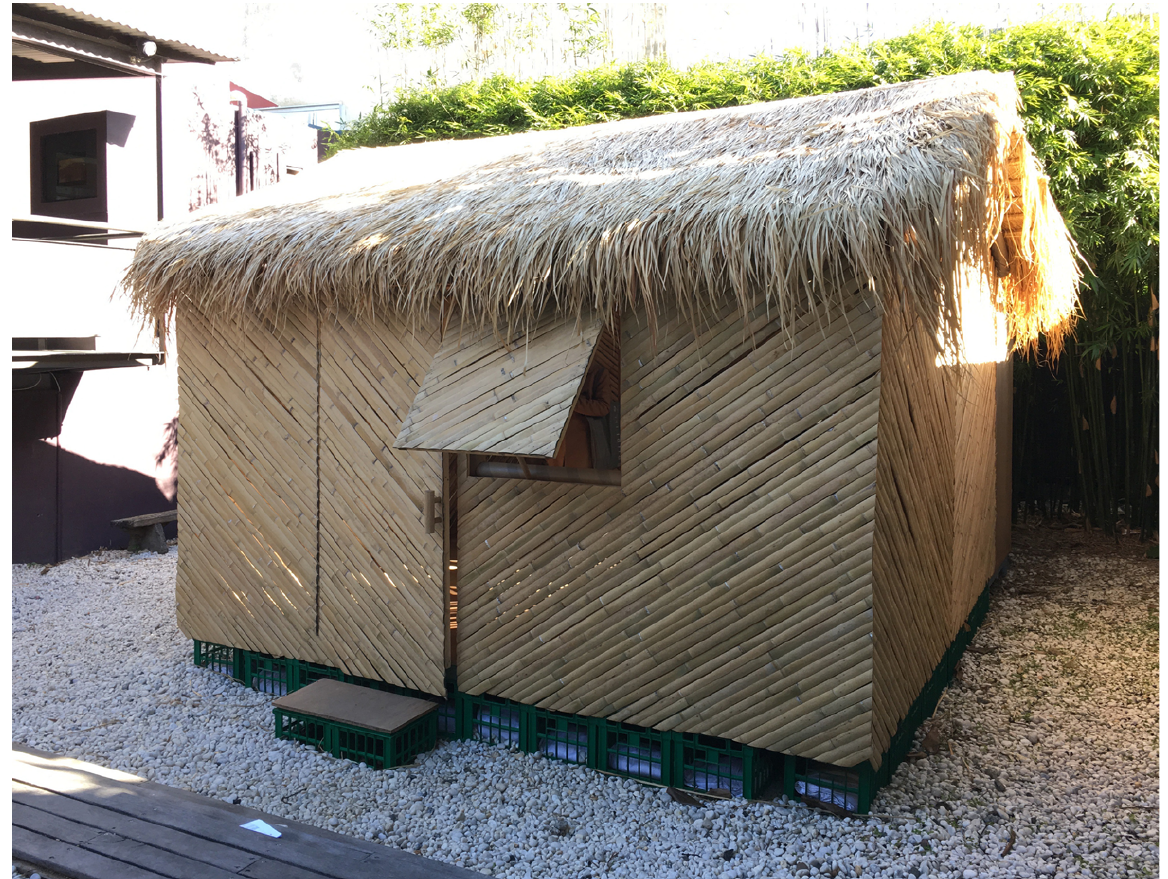
Shigeru Ban Architects, installation view from the 2017 exhibition, The Inventive Work of Shigeru Ban, Sherman Contemporary Art Foundation (SCAF), Sydney. Source: Photograph by Susan Holden,